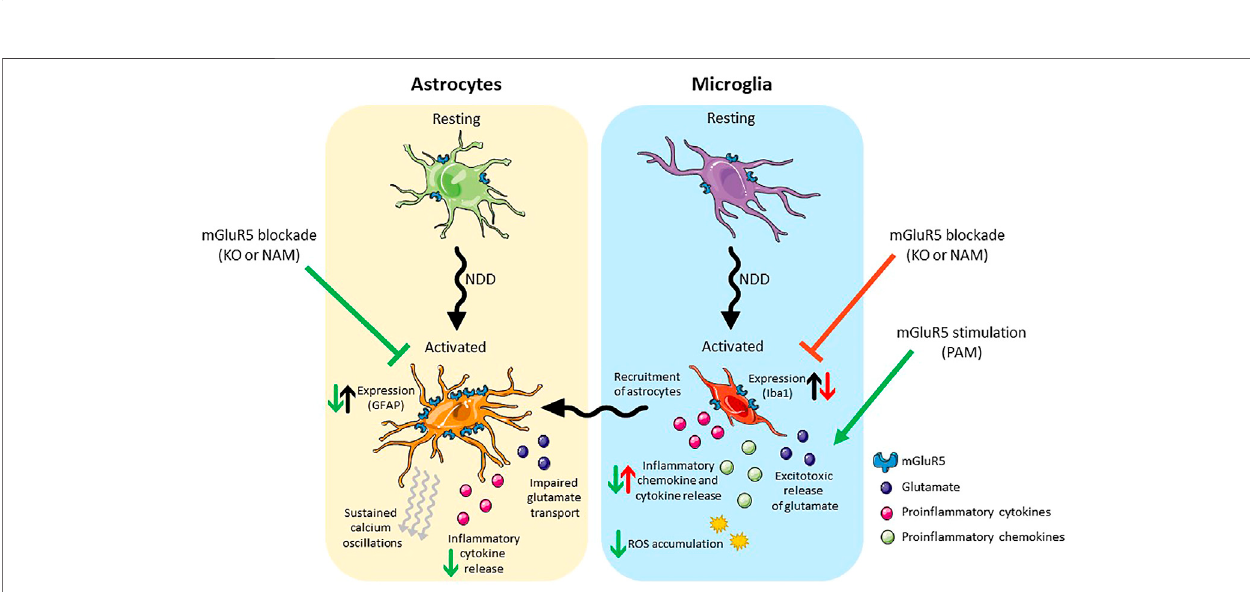
FIGURE 2 | Schematic presentation of the effects of mGlu 5 allosteric modulation on astrocytes (left) and microglia (right). Under pathological conditions both cell types take on an activated phenotype. Activated astrocytes have an increase in mGlu 5 expression, sustained calcium oscillations, impaired glutamate transport and release pro-in fl ammatory cytokines. Blockade of mGlu 5 , either genetically or pharmacologically, is neuroprotective, reducing GFAP expression and the release of in fl ammatory cytokines. Activated microglia release in fl ammatory cytokines/chemokines and excitotoxic levels of glutamate and result in the ROS accumulation. In addition,theyrecruitactivated astrocytes.BlockadeofmGlu 5 ,eithergeneticallyorpharmacologically reducestheexpressionofIba-1butisneurotoxicinthatitresultsin anincreaseinin fl ammatorychemokine/cytokinerelease.StimulationofmGlu 5 withaPAM,ontheotherhand,isneuroprotectiveandreducesthereleaseofin fl ammatory cytokines/chemokines and the accumulation of ROS. Abbreviations: NDD, neurodegenerative disease; KO, knockout; NAM, negative allosteric modulator; PAM, positive allosteric modulator; GFAP, Glial fi brillary acidic protein; Iba-1, Ionised calcium binding adaptor molecule 1; ROS, reactive oxygen species. Figure created using Reactome Icon Library, licensed under CC BY 4.0 (Sidiropoulos et al.,